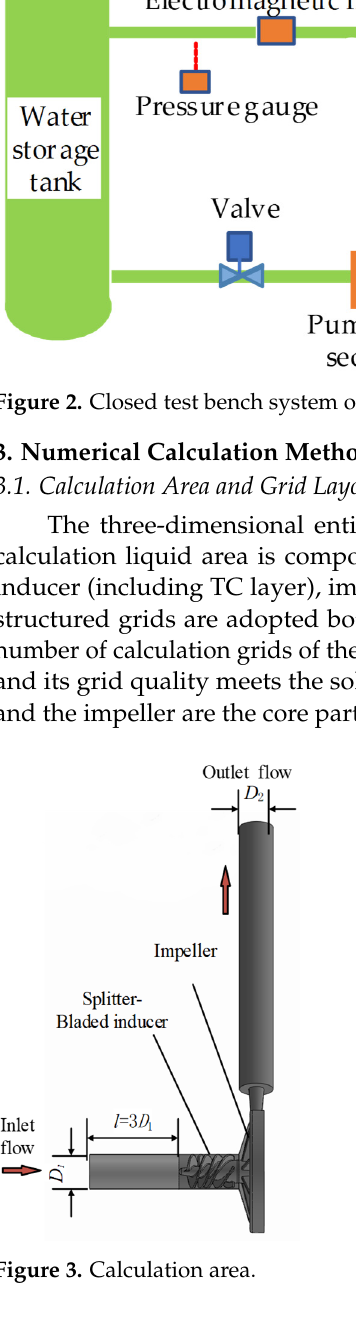
Figure 4. Local area grid of the inducer and the impeller. 3.2. Validation of Grid Independence The effect of six different densities of grid on the head was investigated under the design conditions. The results of the independent tests are shown in Figure 5. As can be seen, when the number of grid elements exceeds 9.15 million, the head changed by less than 0.1%.